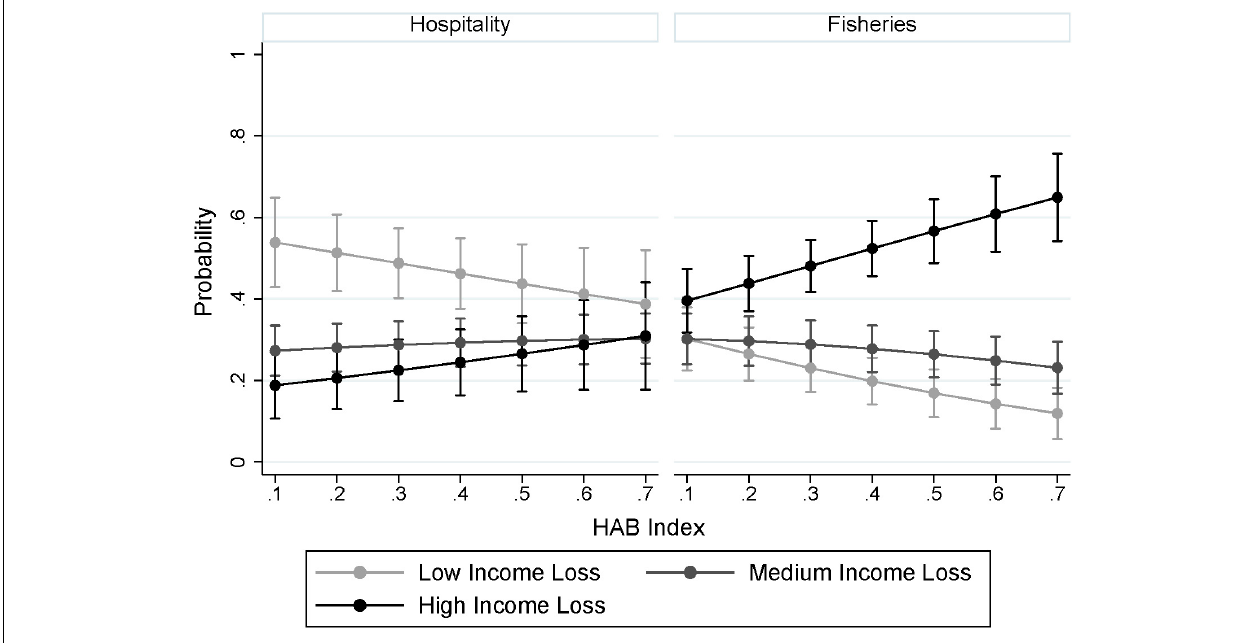
FIGURE 1 | The effect of HAB fisheries closure extent on the probability of income loss level by employment industry.